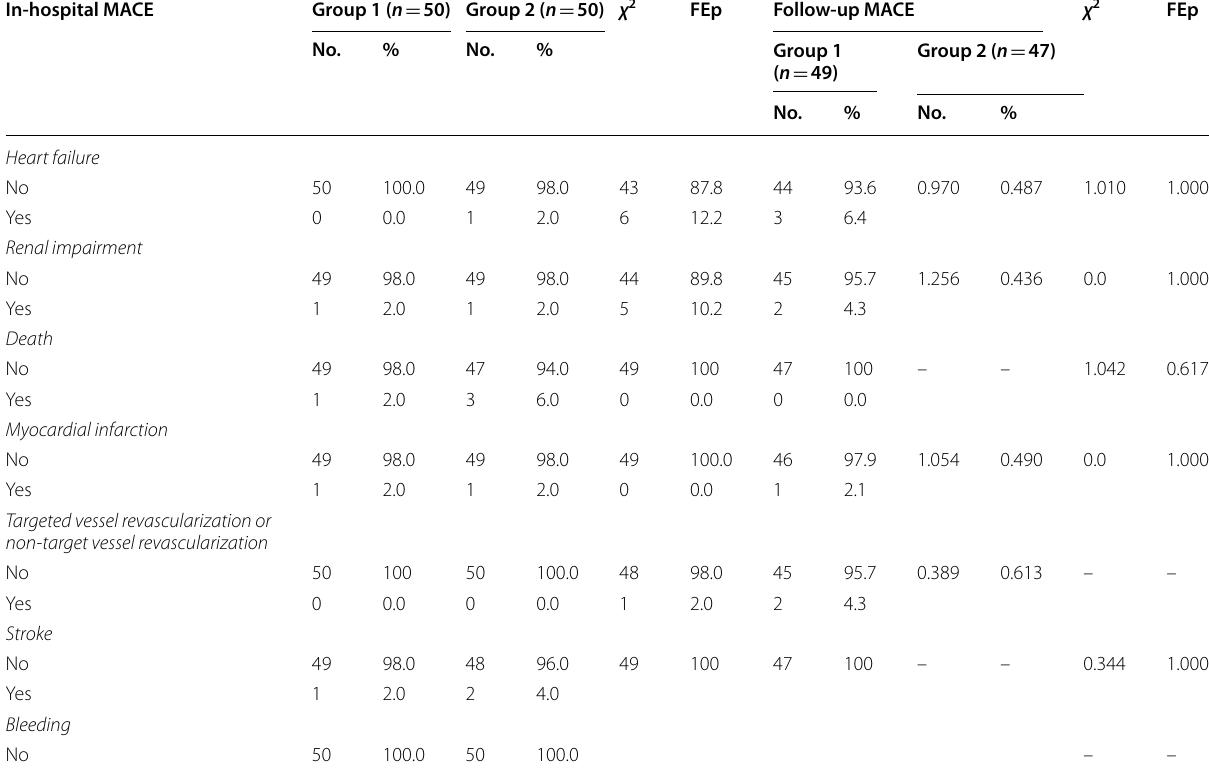
χ 2 Chi-square test, FE Fisher exact, p p -value for comparing between the two studied groups, Group 1 Patient treated with PCI and drug-eluting stents, Group 2 Patient treated with CABG